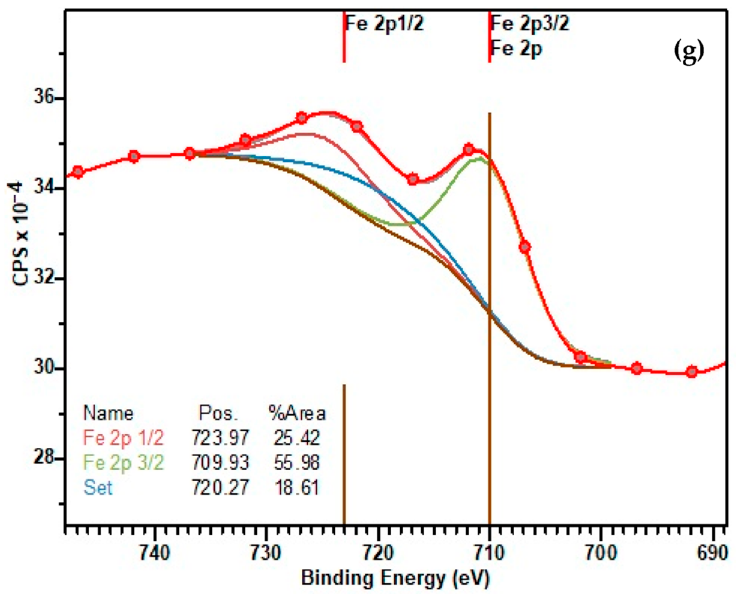
Materials 2023 , 16 , x FOR PEER REVIEW Figure 6. XPS spectra of single element ( a ) O 1s; ( b ) Bi 4d; ( c ) Bi 4f; ( d ) Bi 4s; ( e ) Bi 4p; ( f ) C 1s; ( g ) Fe 2p.